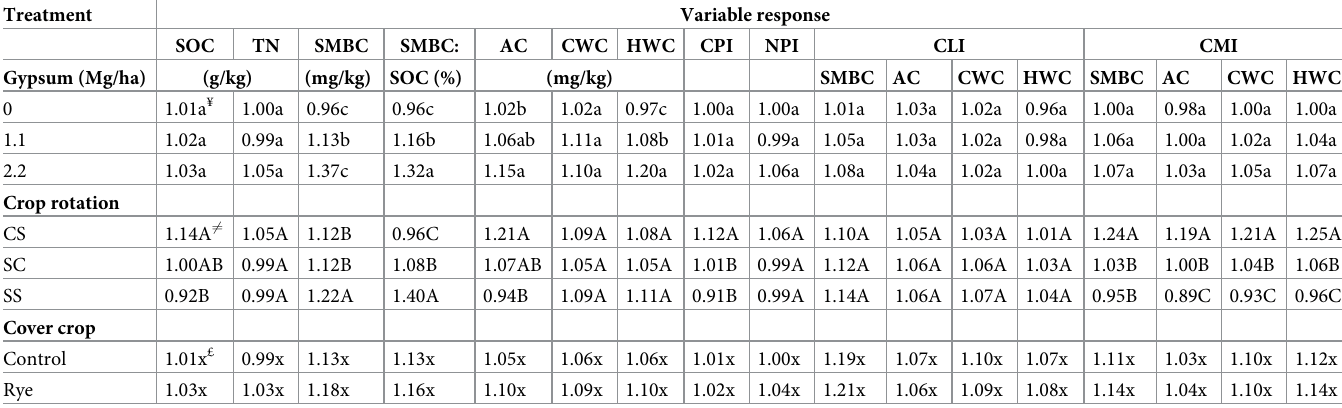
where the 2.2 Mg gypsum/ha was applied (Table 1). In contrast, the CMI, a composite measure of SOC accumulation and lability, was significantly affected (by 12 to 13%) via a change in SMBC by the impact of the 2.2 Mg/ha gypsum application in both Alabama and Ohio-Hoyt- ville sites. When the data on SOC pools, total N, and SOC lability were normalized at each site, fol- lowed by an across-sites analyses (i.e., a meta-analysis), SMBC (by 41%), SMBC:SOC (by Table 5. Gypsum and cover crop impacts on normalized values of total soil organic C (SOC), total nitrogen (TN), microbial biomass (SBMC), active carbon (AC), cold (CWC) and hot (HWC) salt water extractable carbon, carbon pool index (CPI), nitrogen pool index (NPI), carbon lability index (CLI) and carbon management index (CMI) under different phases of a rainfed no-till soybean-corn rotation when averaged across all sites (2012 to 2016). Treatment